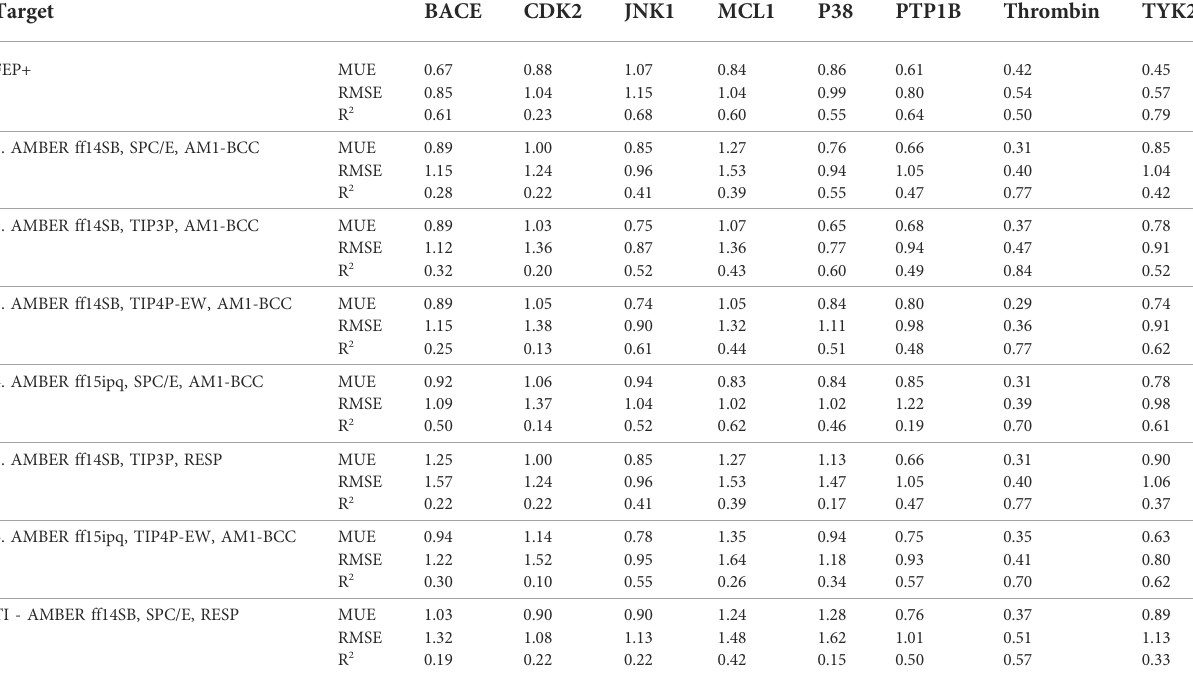
TABLE 4 Summary of MUE, RMSE and R 2 of 8 test cases and parameters.